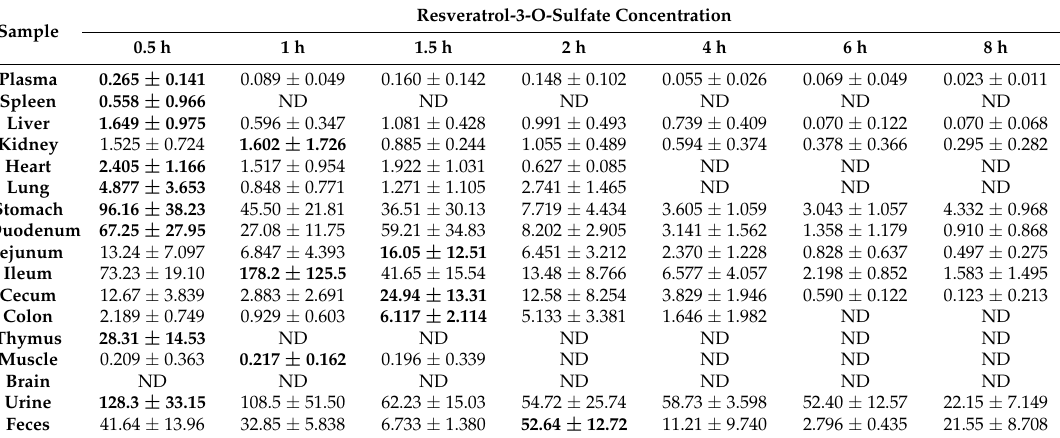
Table 3. Distribution of resveratrol-3-O-sulfate in plasma (nmol/mL), various organs (nmol/g of tissue), urine (nmol/mL), and feces (nmol/g wet content) in mice at different time-points following the intragastric administration of resveratrol at a single dose of 10 mg/kg. Maximum concentrations (C max values) are in